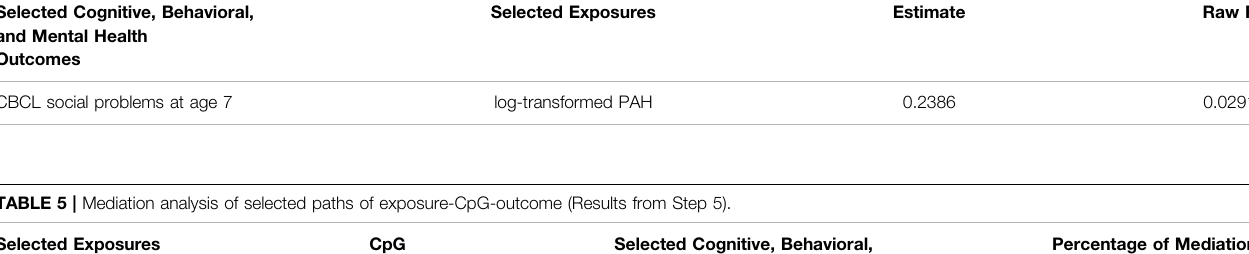
TABLE 4 | Association tests between outcome and selected exposures which were signi fi cantly associated with some outcome-related CpGs (Output from Step 4). Selected Cognitive, Behavioral, and Mental Health